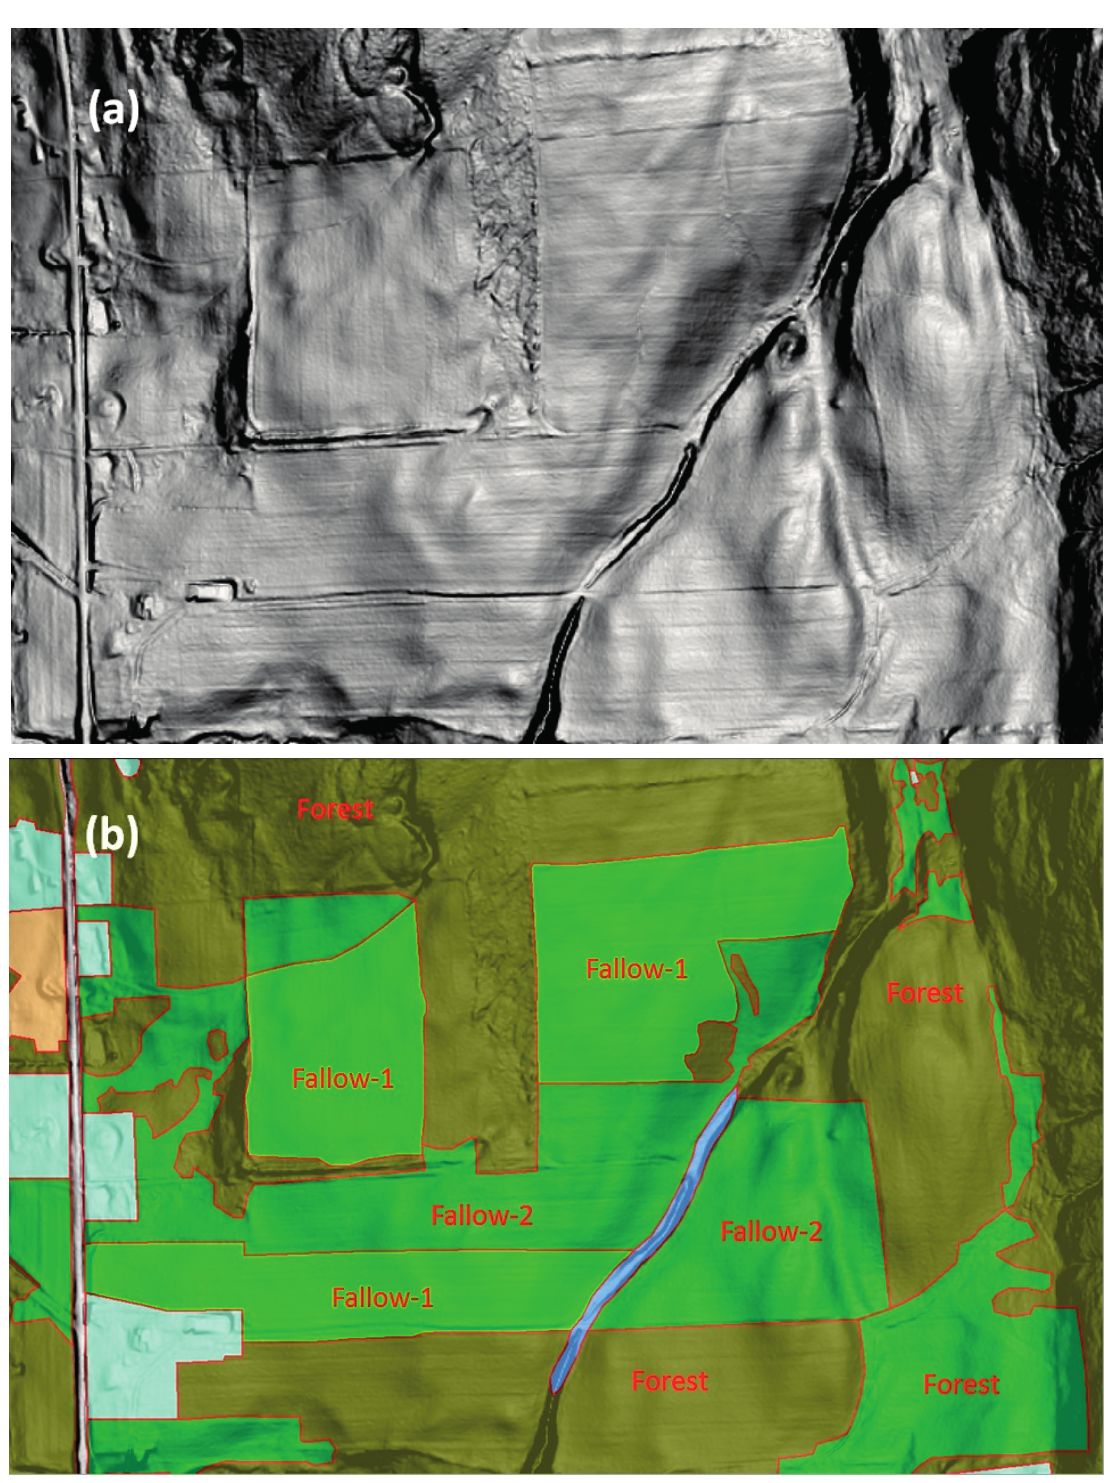
Figure 5. LiDAR-derived ground slope raster layer ( a ) clearly reveals old cultivated land characterized by smooth surface and fine linear features as a result of long-time tilling, some of which are either fallow-2 or completely forested as indicated in ( b ) and shown in Figure 2c. The extent of both maps is identical to Figure